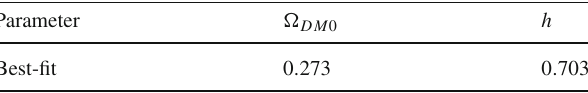
Table 3 The best-fit values for the (cid:6) CDM model using the same data